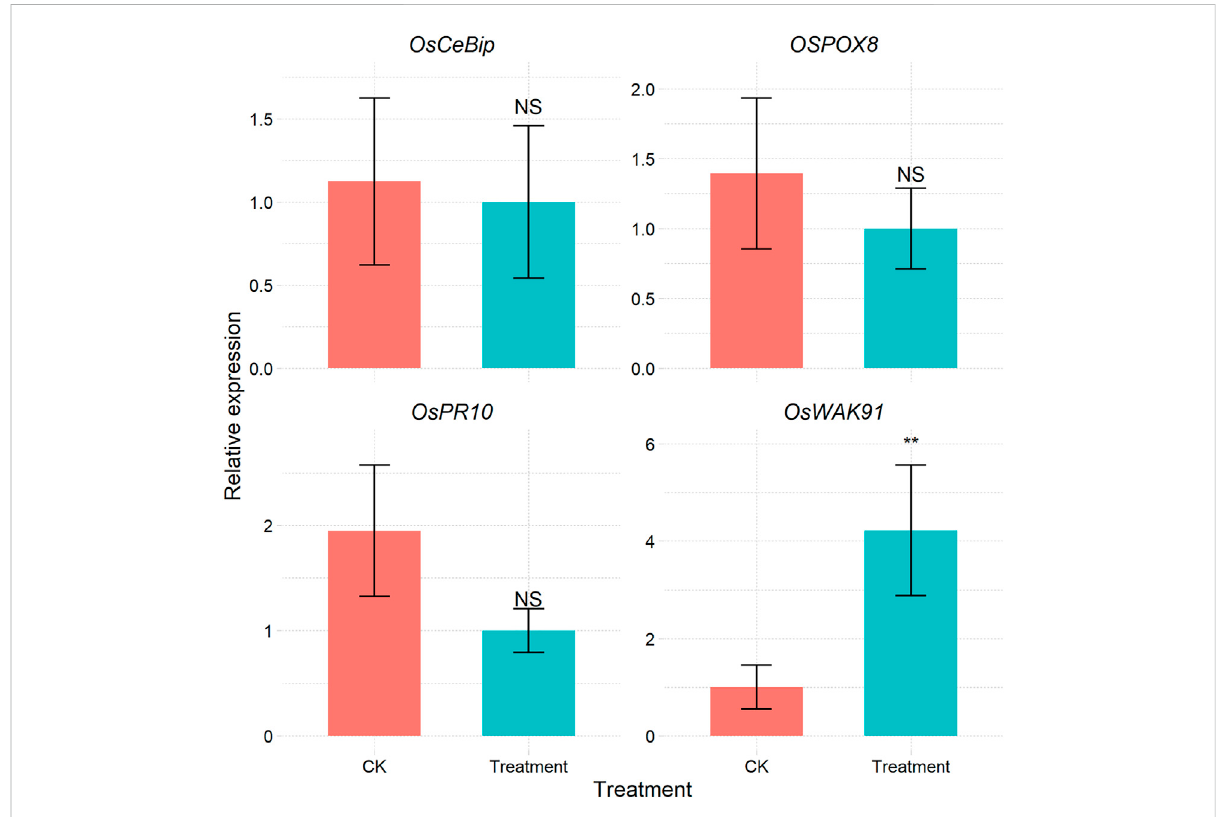
FIGURE 4 Bar plot of the relative expression of each gene under different treatments calculated via the RqPCR